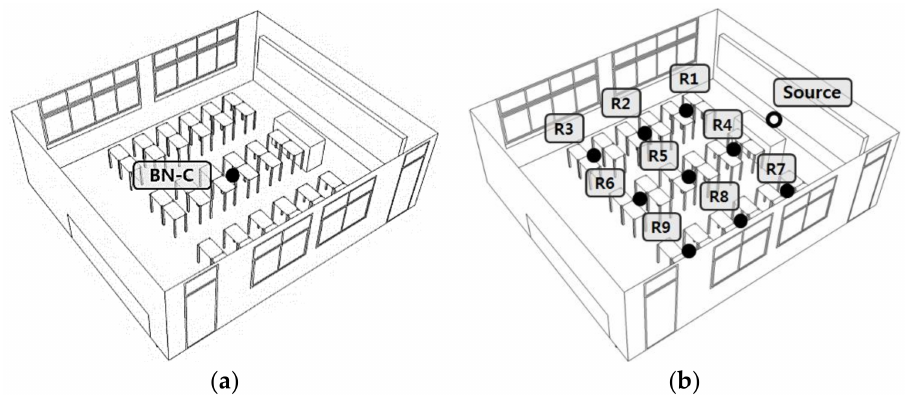
Figure 1. The location of sound sources and receiving points for measurements in the classroom. ( a ) Background noise level; ( b ) reverberation time, T 30 .